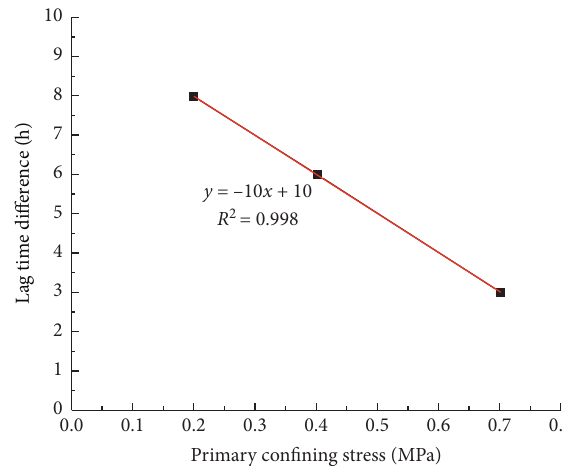
Figure 12: Relationship between lag time difference and initial limit.